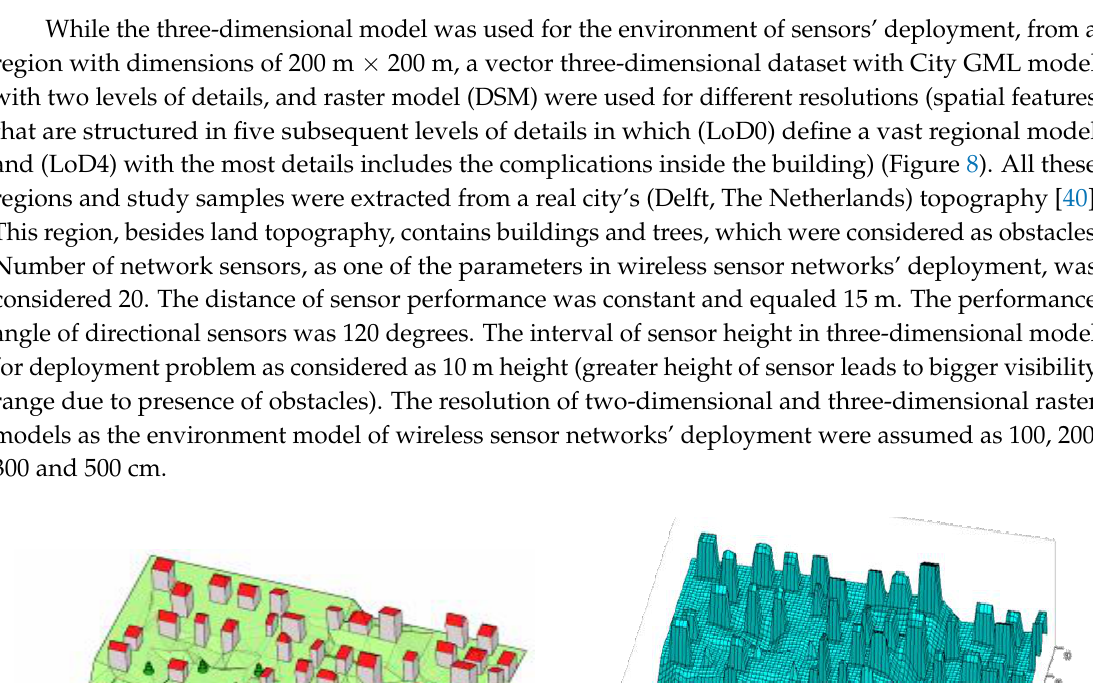
Figure 7. ( A ) vector model; and ( B ) raster model with resolution of 100 cm.